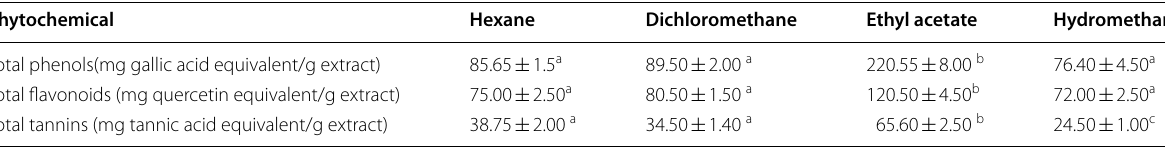
moderate amount, + + =